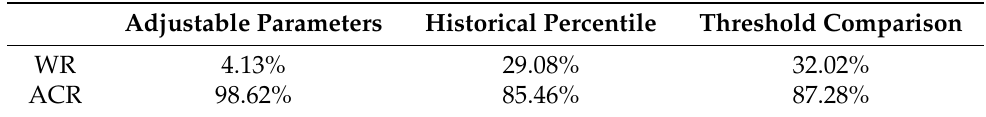
Table 9. Comparison of different early-warning